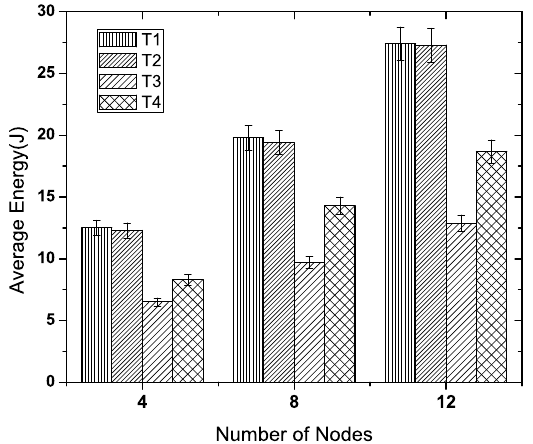
Figure 12. Average energy consumption of diverse periodic traffic at varying network